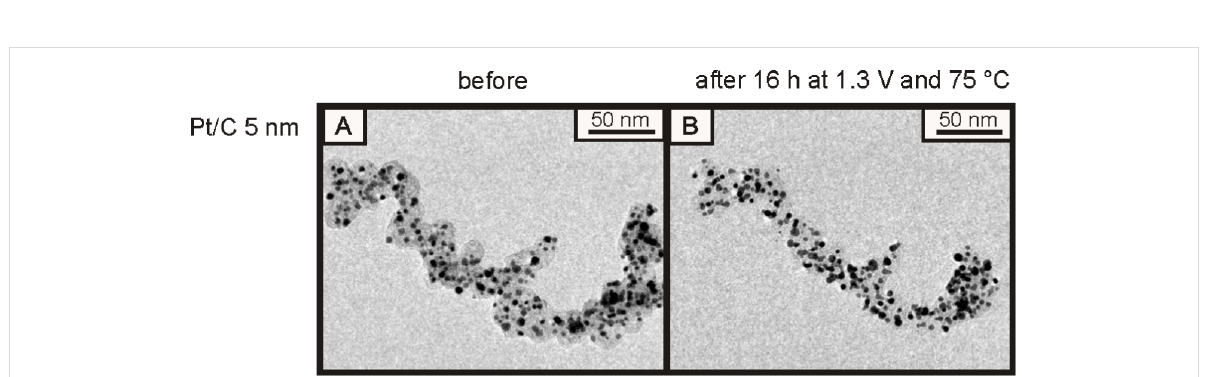
Figure 10: IL-TEM micrograph of Pt/C 5 nm subjected to 1.3 V RHE at 348 K (75 °C) for 16 h in 0.1 M HClO 4 . A shrinkage of the carbon support due to carbon corrosion with successive decrease in inter-particle distances and coalescence can be observed. The images were reprinted with permission from [49]. Copyright 2011 Elsevier.